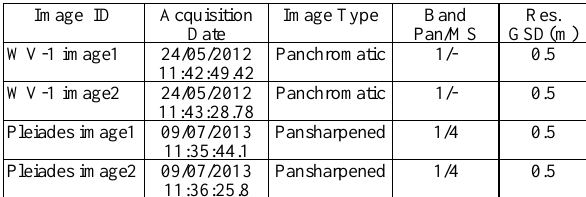
Table 1. Characteristics of the used satellite imageries